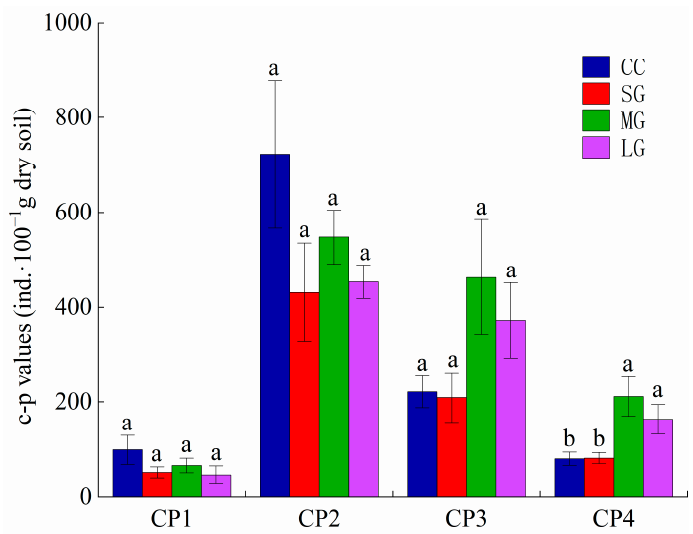
Figure 3. The colonizer-persister (c-p) values of the four habitats (mean ± SE, n = 9). Lowercase letters indicate differences within treatments at the p < 0.05 level. CC, closed canopy; SG, small gaps; MG, medium gaps; LG, large gaps. CP1, CP2, CP3, and CP4 are the colonizer-persister scales from 1 to 4.